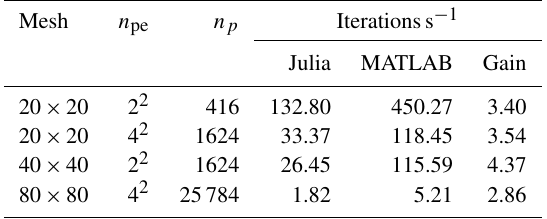
Table 1. Efficiency comparison of the Julia implementation of Sinaie et al. (2017) and the MATLAB-based implementation for the two elastic disc impact